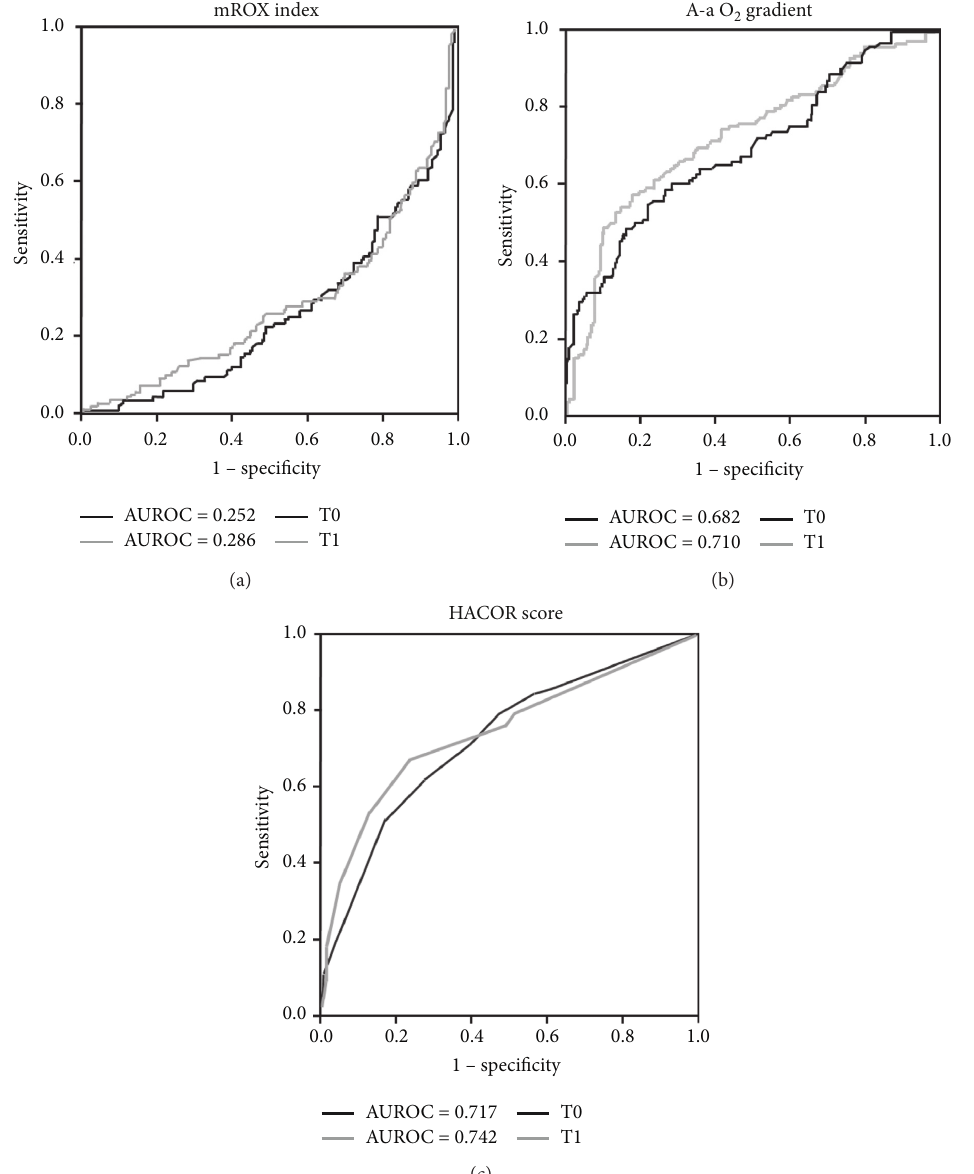
Figure 1: Accuracy of predictors of CPAP failure. Receiver operating characteristic (ROC) curves with areas under the ROC curves showing the performance for mROX index (a), A-a O 2 gradient (b), and HACOR score (c) in predicting CPAP failure at T0 (black lines) and T1 (grey lines). mROX index � modified ROX index (PaO 2 /FiO 2 /respiratory rate); A-a O 2 gradient � alveolar-arterial oxygen gradient; HACOR � heart rate, acidosis (pH), consciousness (Glasgow coma scale: GCS), oxygenation, and respiratory rate score; AUROC � area under the receiver operating characteristic